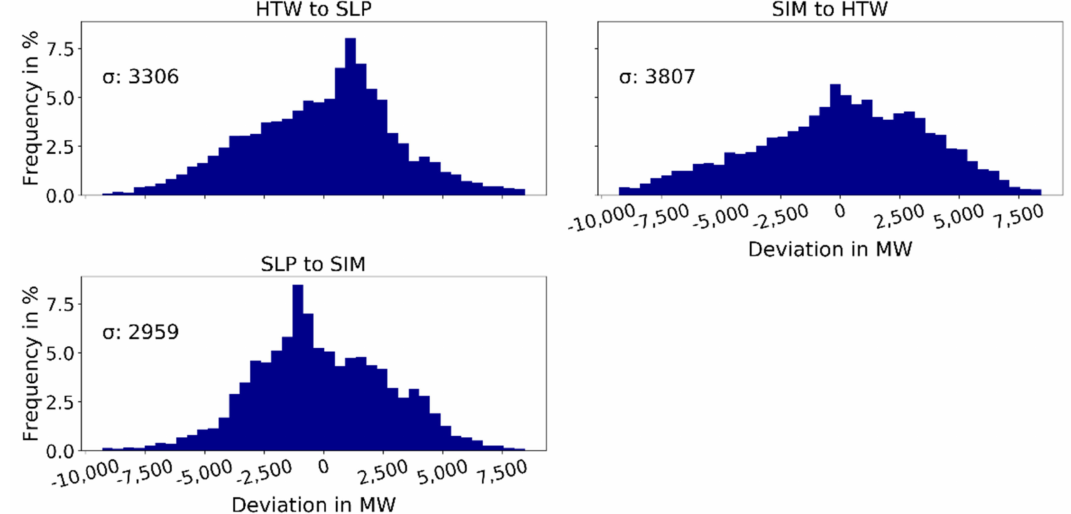
Figure A7. Deviation in load between our simulation, measurements from the HTW Berlin, and the German standard load profile H0 for Germany. Values shown are for 8760 h in the weather year 2012. The annual consumption is 134 TWh (average load of 15.3 GW) and is identical for all three profiles.